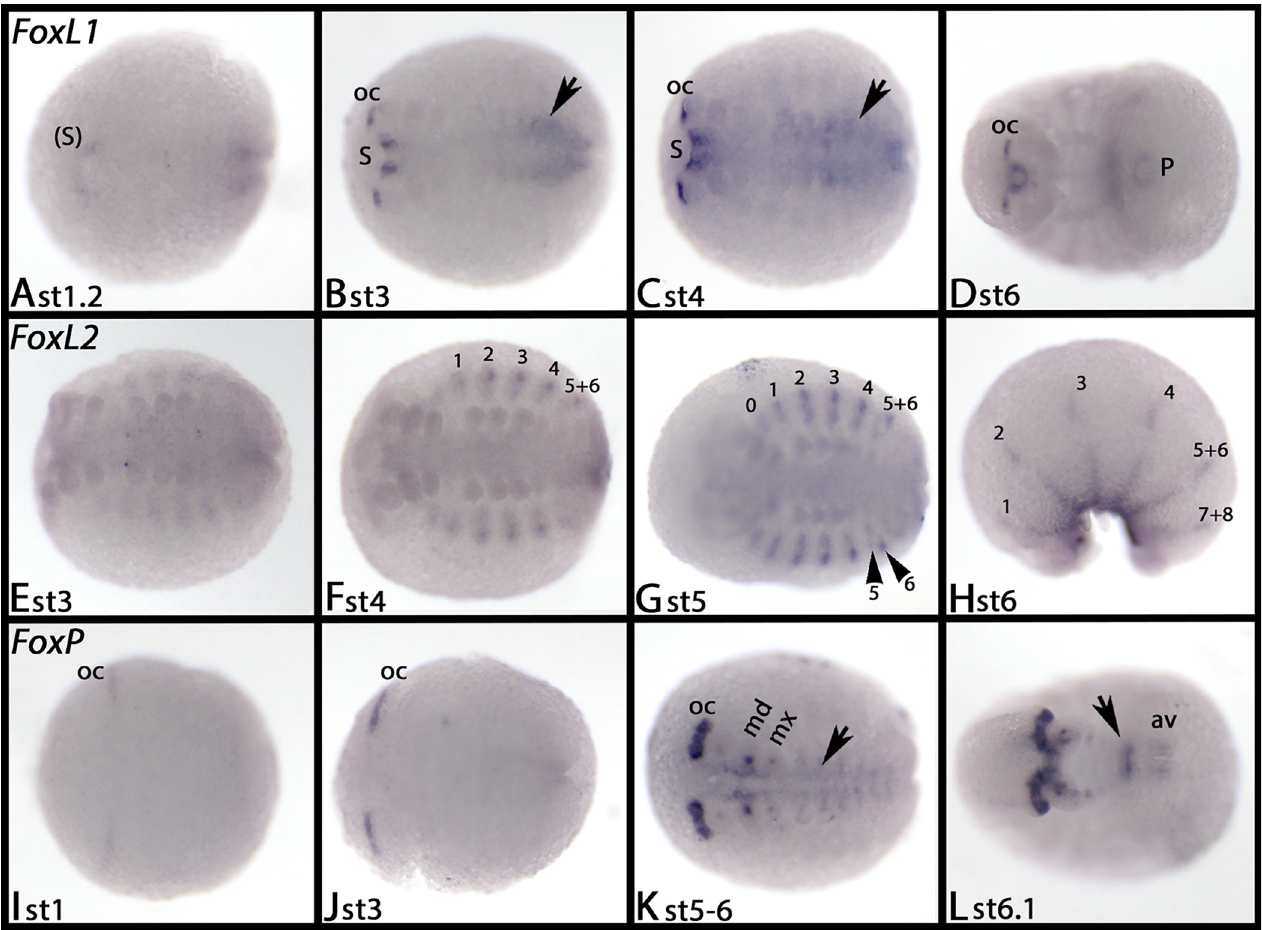
Fig 16. Expression of Glomeris FoxL1 (A-D), FoxL2 (E-H), and FoxP (I-L). In all panels, anterior is to the left, ventral views (except panel H, lateral view). Arrows in panels B and C point to expression in the developing midgut. Arrowheads in panel G point to two domains of expression in a fusing dorsal segmental unit. Roman numerals mark expression in the dorsal segmental units (cf. Janssen 2011). The arrow in panel K points to expression in the VNS. The arrow in panel L points to expression in the last formed segment. Abbreviations in Table 2.